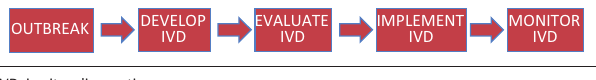
FIGURE 1: Pathway toward implementation of outbreak-use in vitro